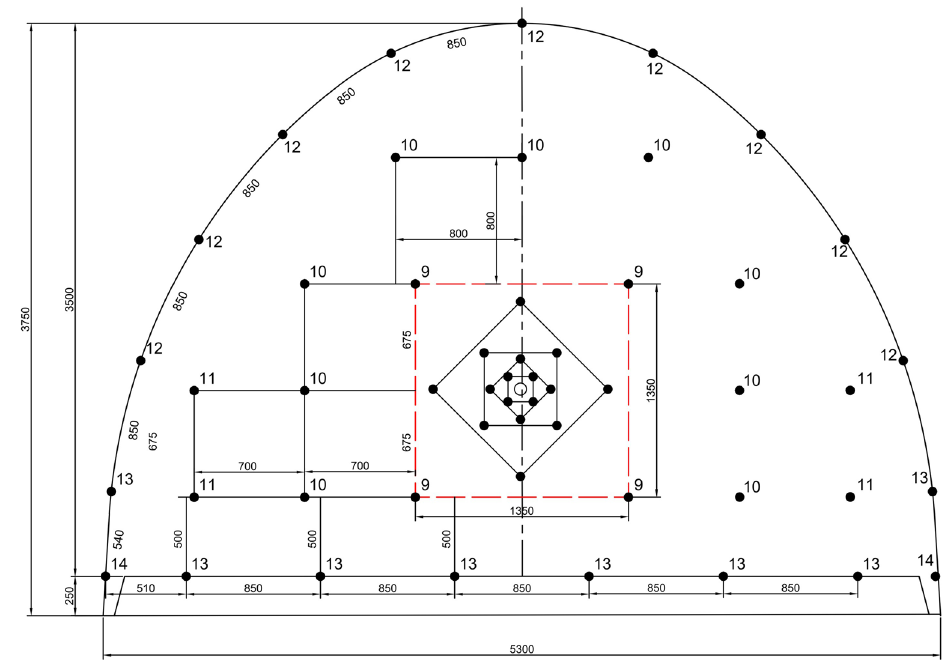
Figure 10. The arrangement of blastholes and firing sequences in excavation of 14 m 2 cross-section development roadway for 76 mm empty hole diameter (see Fig. 9 for cut details).